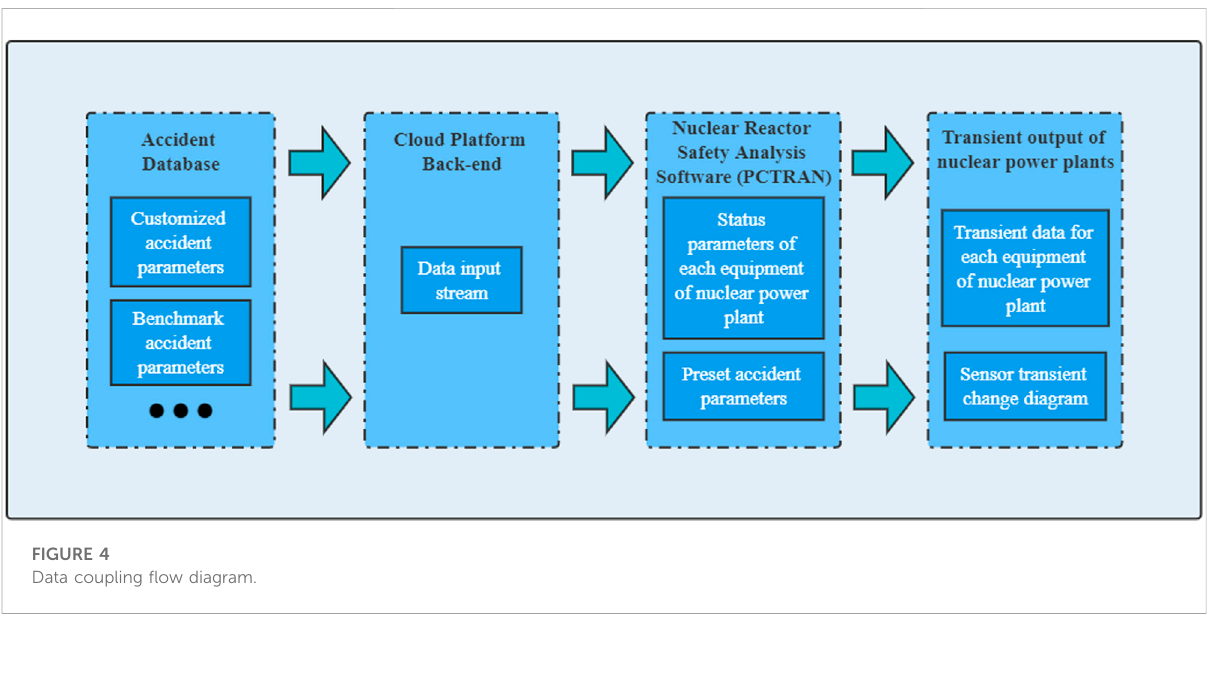
TABLE 1 Con fi guration table of server hardware.